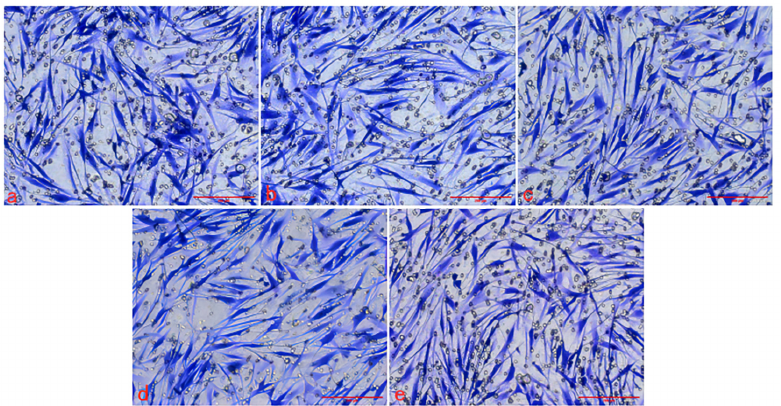
Figure 8. The Transwell cell migration map of HSFs labeled with AGQDs. ( a – e ) are 0 μ g/mL, 50